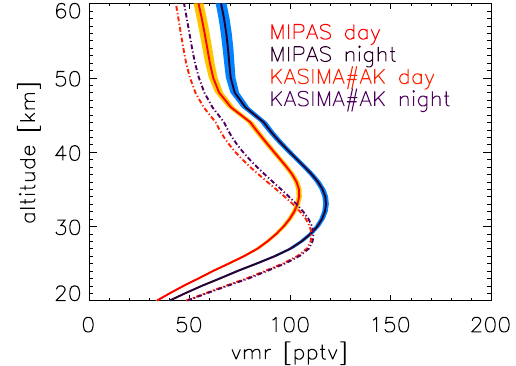
Fig. 11. Day (red) and nighttime (blue) H 2 O 2 vmr for MIPAS (solid) and KASIMA with MIPAS A applied (dash-dotted) aver- aged between 20 ◦ N and 20 ◦ S for the full data period; For MIPAS the 3-sigma error bar is shown.